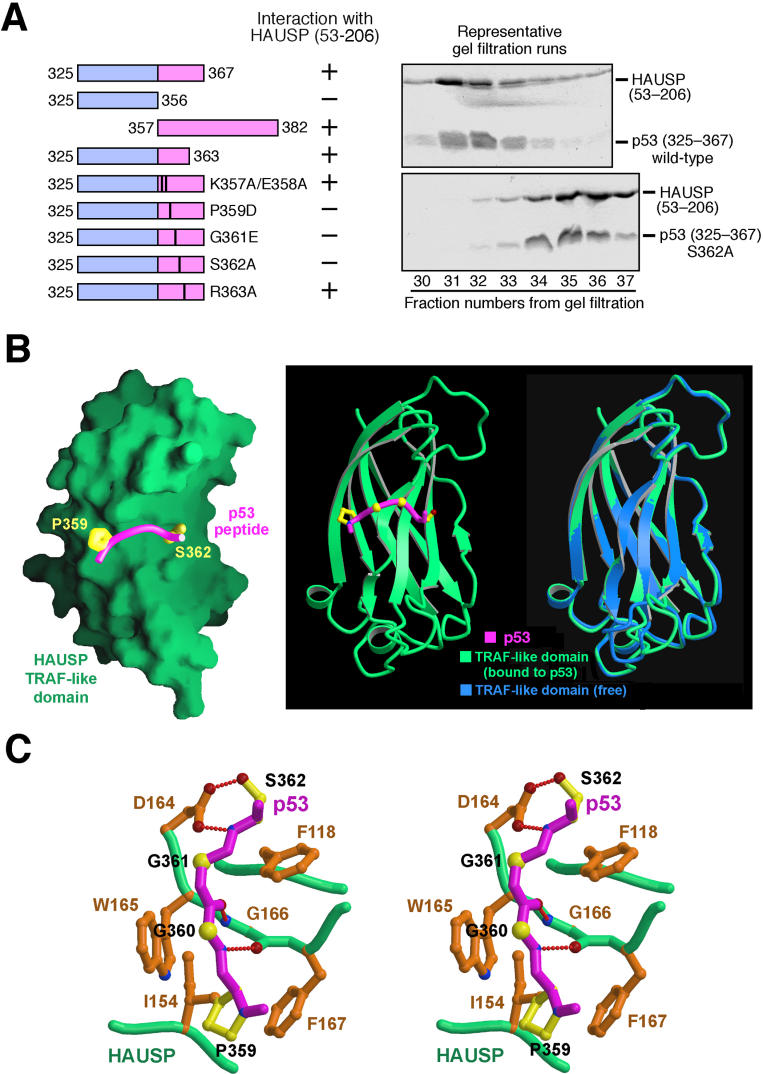
Structural Basis of p53 Recognition by HAUSP(A) Identification of a short-peptide fragment in p53 (residues 359–362) as the HAUSP-binding element. Various p53 fragments were individually incubated with HAUSP protein (residues 53–206) and their interactions were examined by gel filtration. The results are summarized in the left panel. Two representative experiments, for WT p53 (residues 325–367, WT) and mutant p53 (residues 325–367, S362A), are shown on the right panel. Note that, because the elution volumes for free HAUSP (residues 53–206) and for free p53 (residues 325–367) correspond to fraction numbers 36 and 35, these two proteins appear to co-migrate on gel filtration—but they do not interact with each other. The protein concentrations for gel filtration were: HAUSP (53–206), 55 μM; p53 WT, 46 μM; p53 mutant, 51 μM.(B) Overall structure of the HAUSP TRAF-like domain bound to p53 peptide is shown in a surface representation (left) and in a ribbon diagram (right). Binding by the p53 peptide does not induce any significant conformational changes in HAUSP as shown by the structural comparison of the free and p53-bound TRAF-like domain (right panel).(C) A stereo view of the specific interactions between p53 and HAUSP. Hydrogen bonds are represented by red dashed lines. All interacting residues are labeled.